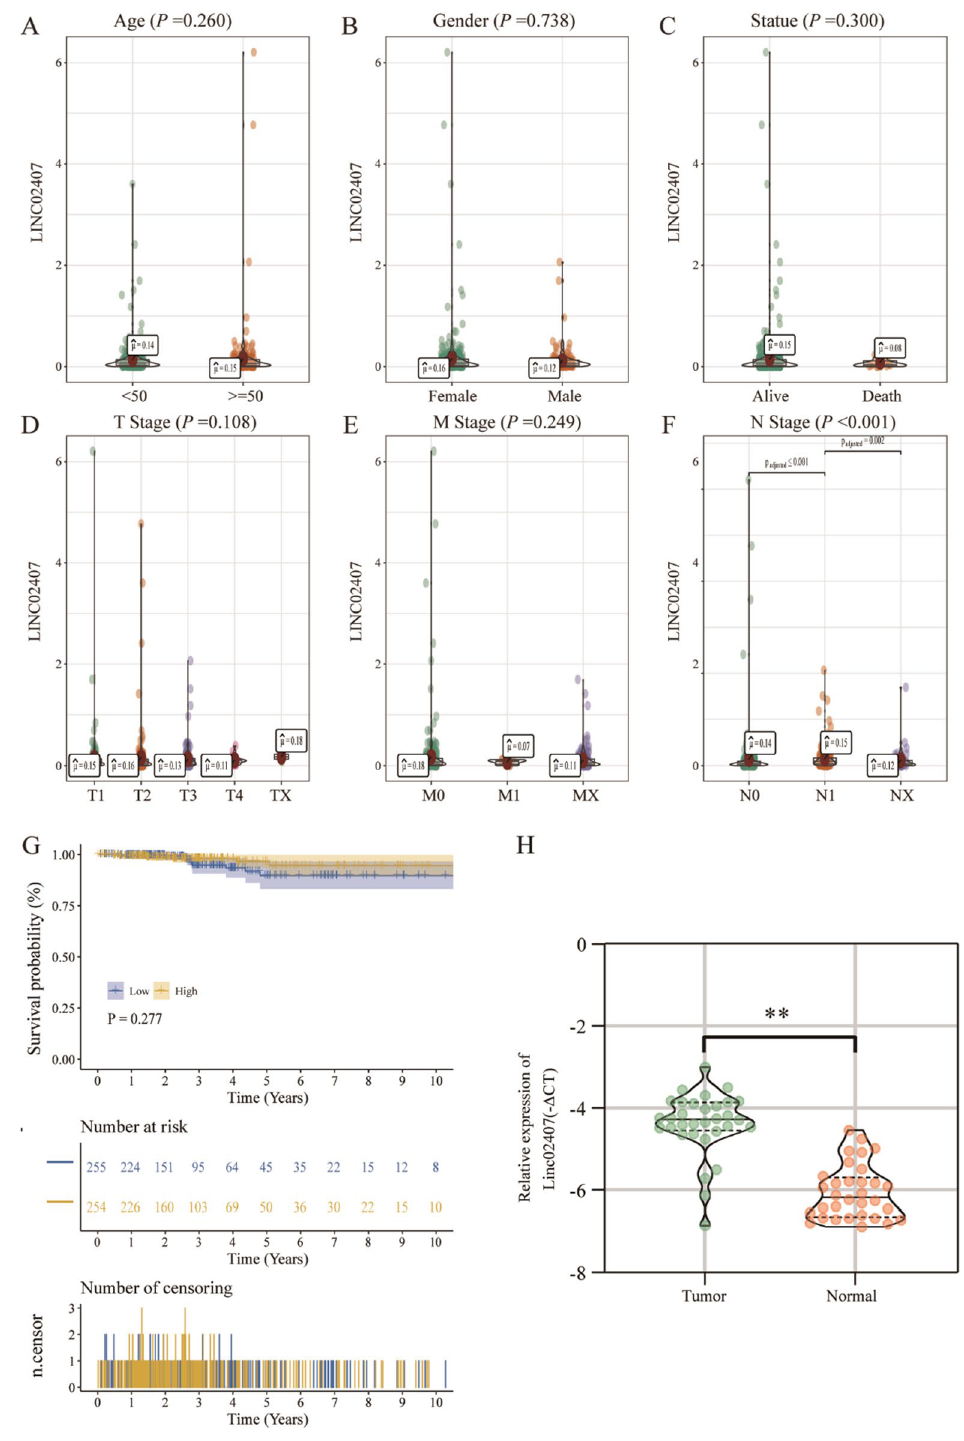
Figure 9. Correlation analysis between clinicopathological characteristics and LINC02407 gene expression in patients with THCA: ( A ) age, ( B ) gender, ( C ) status, ( D ) T stage, ( E ) M stage, and ( F ) N stage. LINC02407 expression and the N stage in patients were significantly correlated ( P < 0.001), wherein the other clinical features, including age, gender, T stage, and M stage, did not show a correlation ( P > 0.05). ( G ) Survival analysis of patients with high or low LINC02407 expression (log-rank P = 0.277). ( H ) Differences in the expression of LINC02407 in cancer and normal tissues (n = 32, ** P <